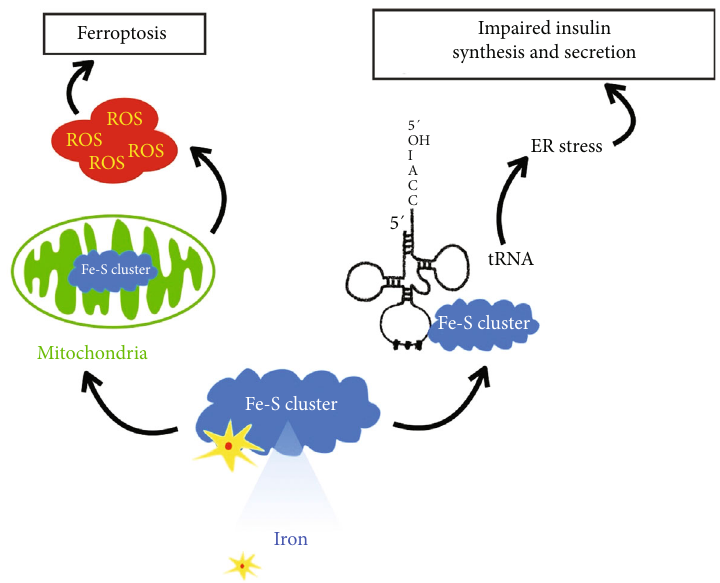
Figure 1: The pathway of Fe-S cluster de fi ciency in T2DM. Fe-S cluster de fi ciency a ff ects the modi fi cation and function of tRNA, resulting in mistranslated proinsulin. This mistranslation can lead to ER stress and impaired insulin synthesis and secretion. Also, iron accumulation and more ROS production due to Fe-S cluster de fi ciency in mitochondria promote lipid peroxidation, further inducing ferroptosis in β -cells. Additionally, ROS directly impairs insulin synthesis and